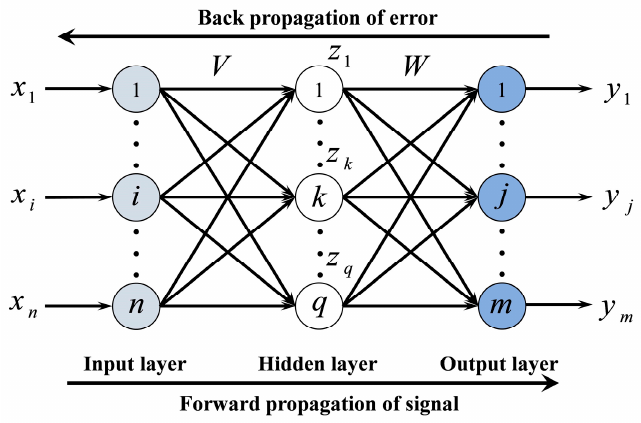
Figure 4. Structure of triple-layer BP neural network.